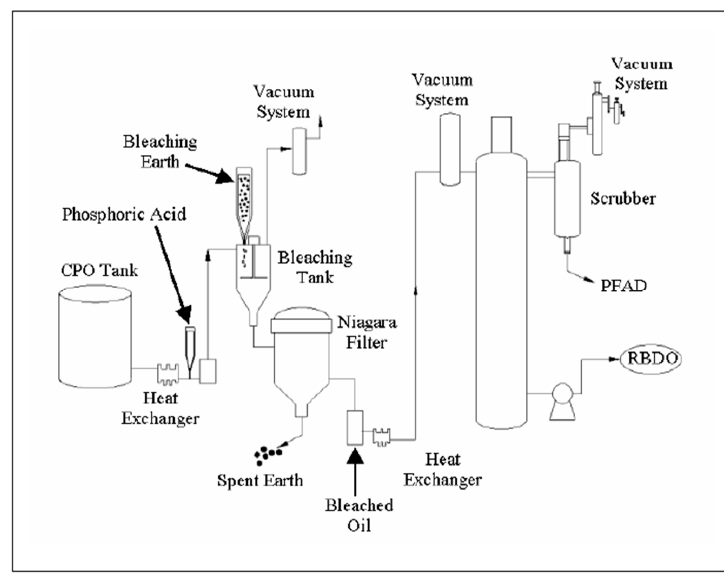
Figure 4. Physical refining process